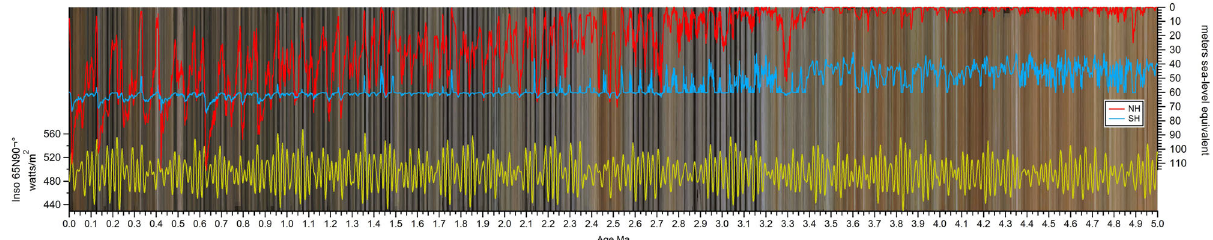
Fig. 2 ODP Site 967 composite core image. Northern and Southern Hemisphere ice-volume changes 79 (NH, red; SH, blue) in equivalent sea-level fall (the SH component includes − 55 m equivalent sea-level for the modern Antarctic ice sheet), and June 21 insolation at 65°N (yellow) illustrate timing relationships between climate forcing and lithology.